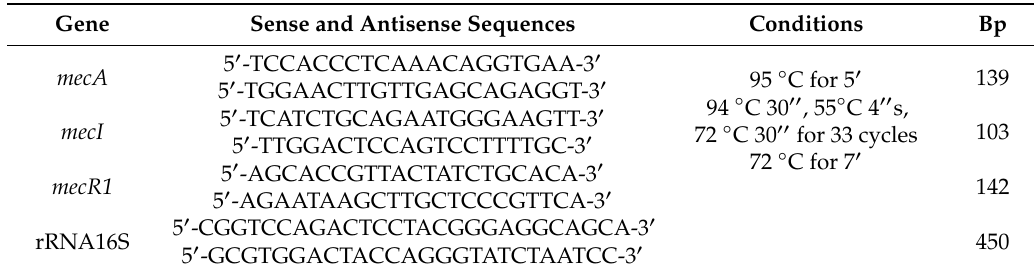
Table 6. Staphylococcal sense and antisense primers sequences and expected polymerase chain reaction (PCR) products